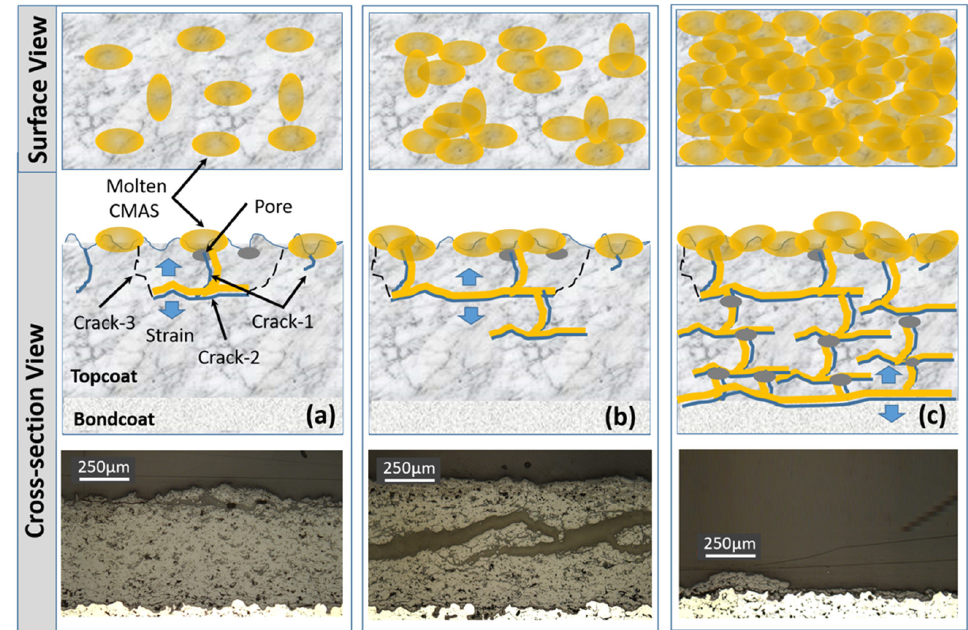
Figure 15. Schematic of the effect of CMAS dosage on the damage mechanisms in the TBC: ( a ) a low dosage with local surface coverage; ( b ) a medium dosage with high surface coverage; ( c ) a high dosage with full surface coverage.